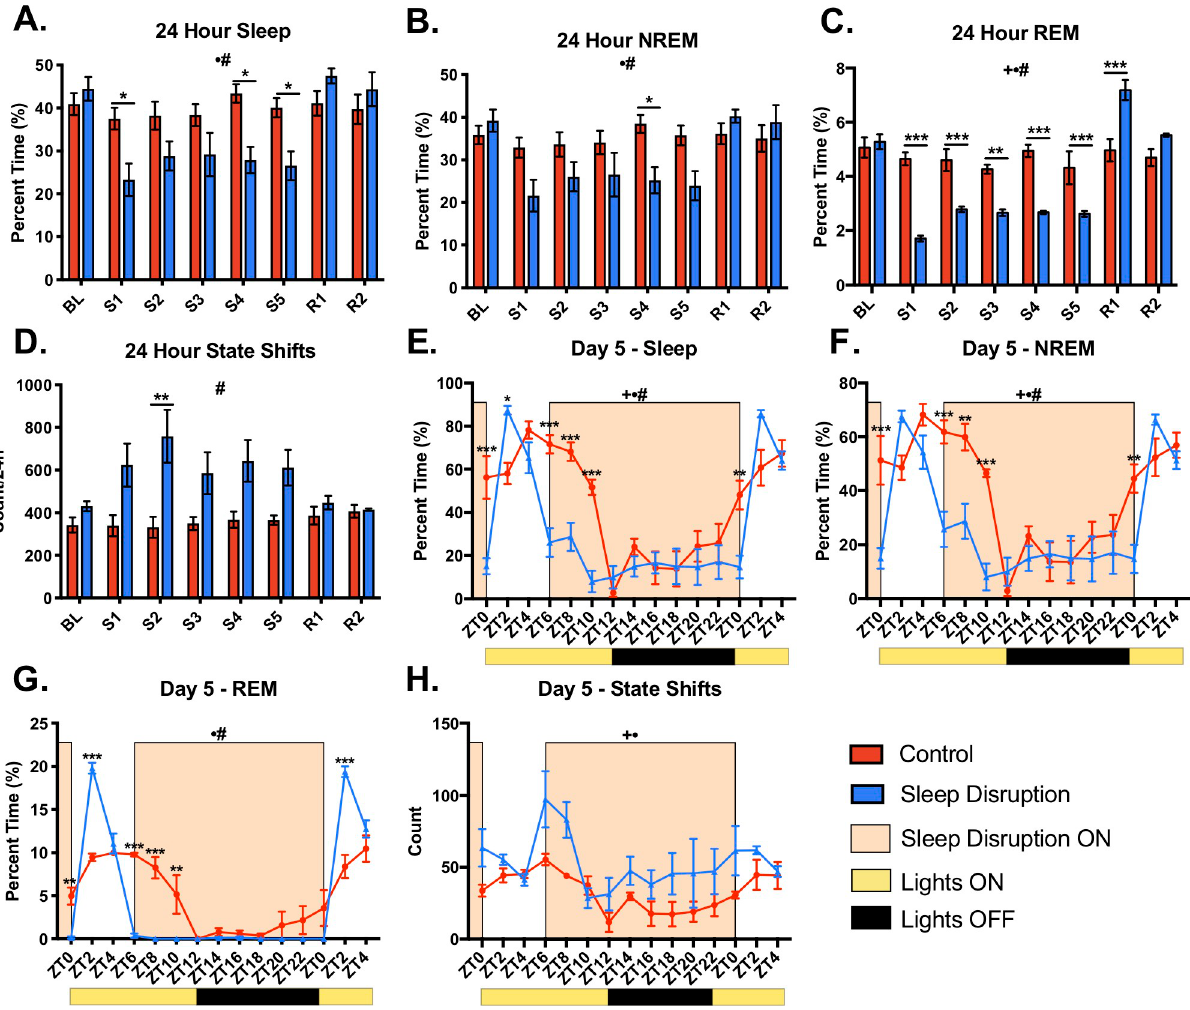
Fig 2. Effect of sleep disruption protocol on sleep measures. A-D) 24-hour totals of total sleep, non-rapid eye movement sleep (NREM), rapid eye movement sleep (REM), and state shifts. There was a significant decrease in sleep, NREM, and REM during the sleep disruption protocol, and an increase in state shifts. E-H) Two-hour bins of total sleep, NREM, REM, and state shifts from the fifth day of the sleep disruption protocol through ZT4 of the first day of recovery sleep. Yellow bars under the x axis indicate the lights being on, while black bars indicate the lights being off. Abbreviations: BL, baseline; S, sleep disruption; R, recovery; ZT, zeitgeber time. n = 3-4/group. � p < 0.05, �� p < 0.01, ��� p < 0.001 (Bonferroni post hoc test); + p < 0.05 (overall effect of sleep disruption over entire time interval, Mixed-effects model); • p < 0.05 (overall effect of Time over entire time interval, Mixed-effects model); # p < 0.05 (Sleep DisruptionxTime interaction over entire time interval, Mixed-effects model).